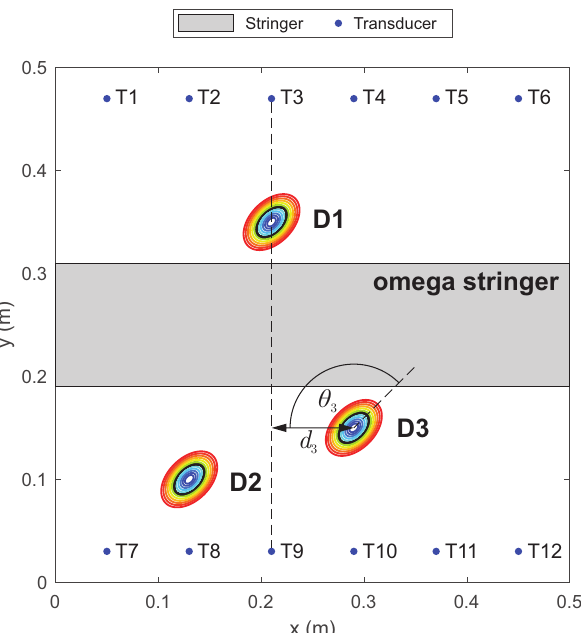
Figure 6. Specimen geometry with the three damage positions D1–D3 relative to the transducer locations T1–T12 ([4]). Considering path T3–T9, d 3 represents the distance from damage D3, while